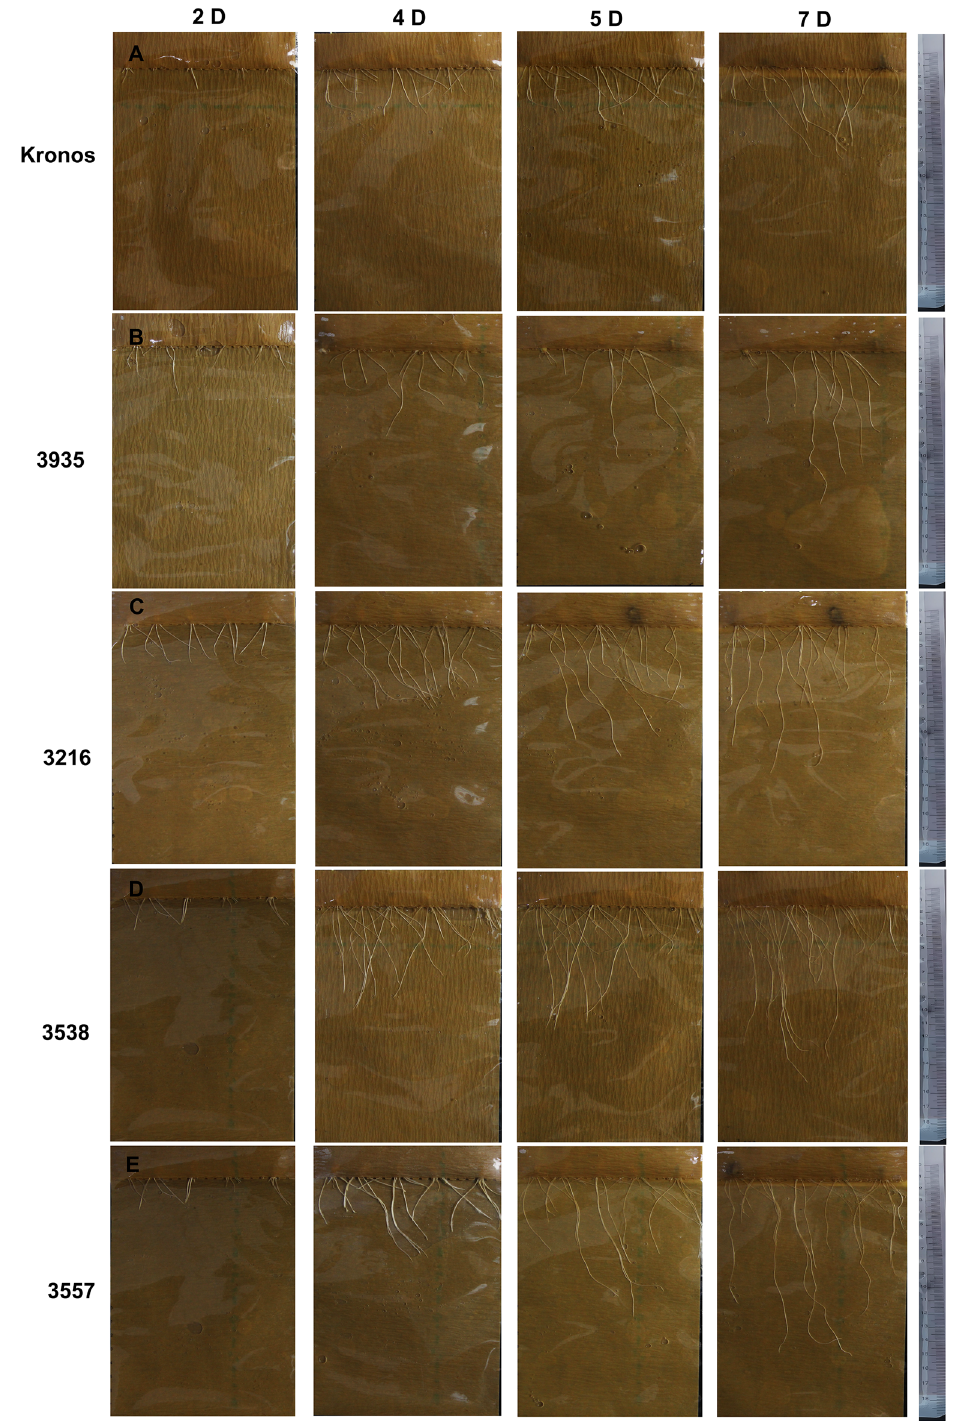
Figure 7. Root growth of Kronos and 4 EMS-induced mutants under the 15% PEG-6000 treatment. ( A ) Kronos root growth conditions. ( B ) Root growth conditions of mutant 3935. ( C ) Root growth conditions of mutant 3216. ( D ) Root growth conditions of mutant 3538. ( E ) Root growth conditions of mutant 3557. Root growth was measured on days 2, 4, 5, and 7.